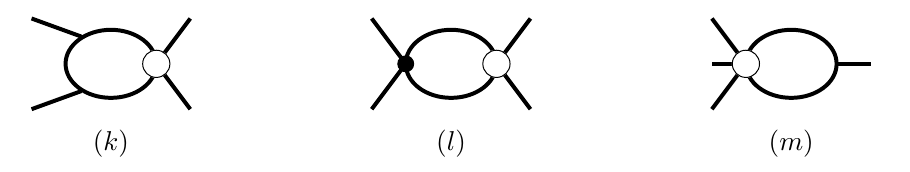
Figure 3 . One-loop diagrams with genus-one quartic or quintic vertex (denoted by a white circle). The term proportional to (cid:3) 2 D (cid:0) 6 generates a logarithmic singularity in D = 3 corresponding to the term proportional to (cid:16) (3) 2 L d (cid:0) 7 in (2.43). Still, this does not exhaust the set of two-loop diagrams which occur in the low energy limit of string theory. First, in addition to the tree-level r 4 p +6 q R 4 quartic vertices, the